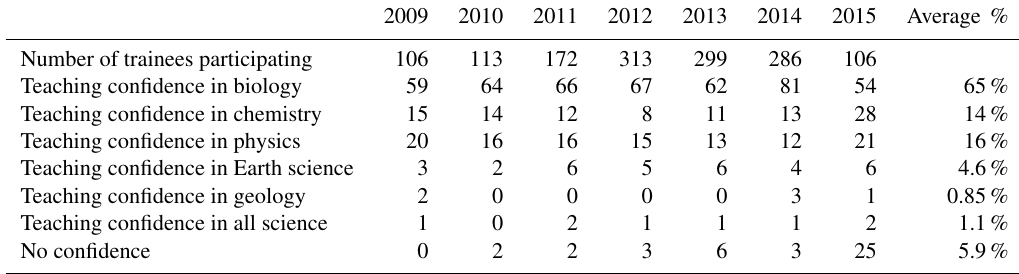
Table 3. Percentage of trainee teachers who felt confident in teaching particular science subjects.